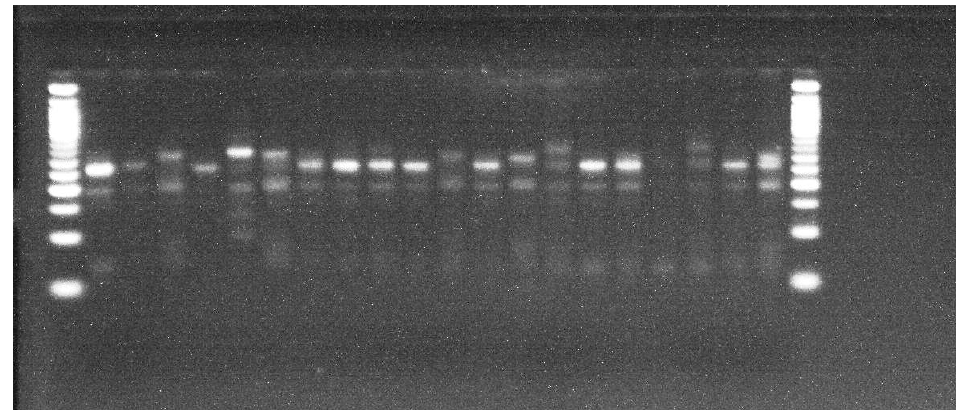
Fig. 4. Polymorphic band for SSR markers (A - RC594-V30156.41) among 20 castor